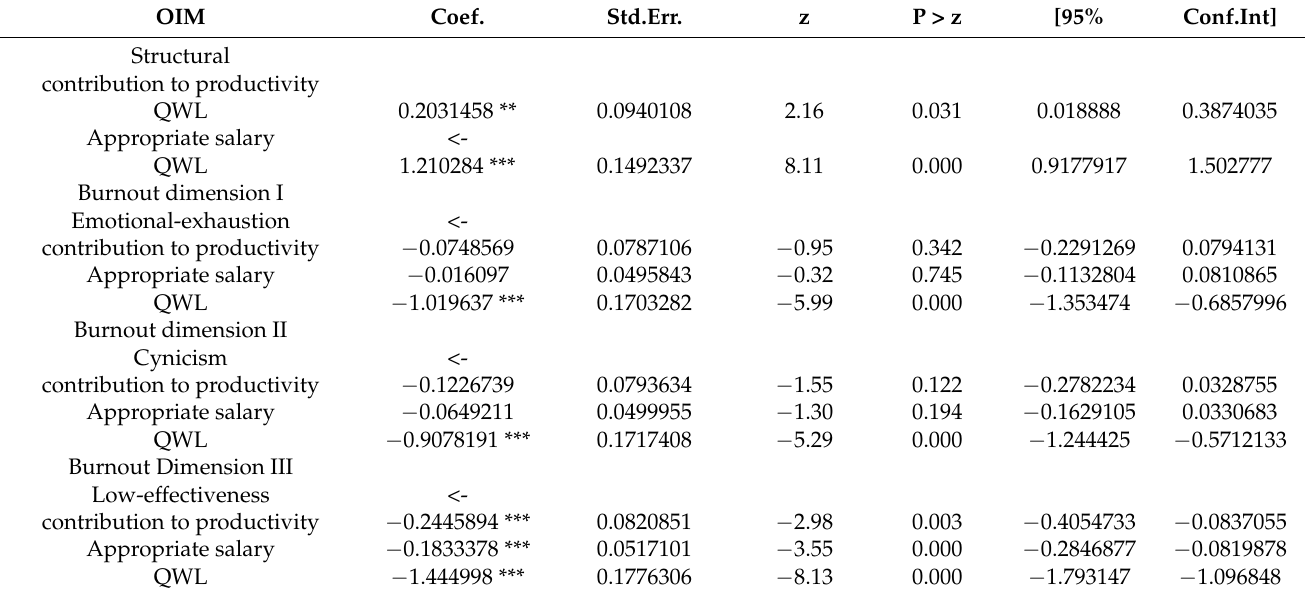
Table 6. Model 2: Direct effects.